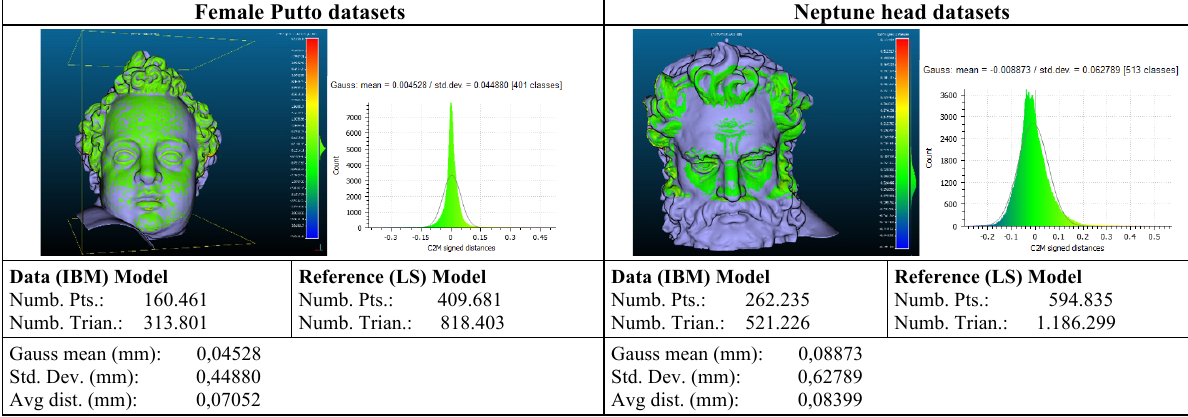
Figure 7. Image Based Polygonal modelling comparison with the ground truth TLS data; the histograms represent the point distribution errors of the mesh-to-mesh alignments: (r) Female Putto dataset; (l) Neptune head dataset. Female Putto datasets Neptune head datasets